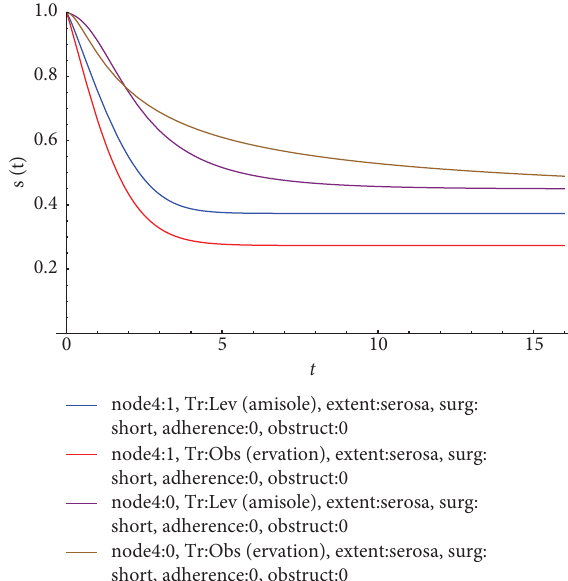
Figure 8: Plots of the survival functions for the colon cancer data based on the PGcr/GeTNH model stratifed by node4 (more than 4 positive lymph nodes (0 � no, 1 � yes)), treatment (Obs (ervation) � 1, Lev (amisole) � 2), extent: serosa, surg: short, adherence: 0, and obstruct: